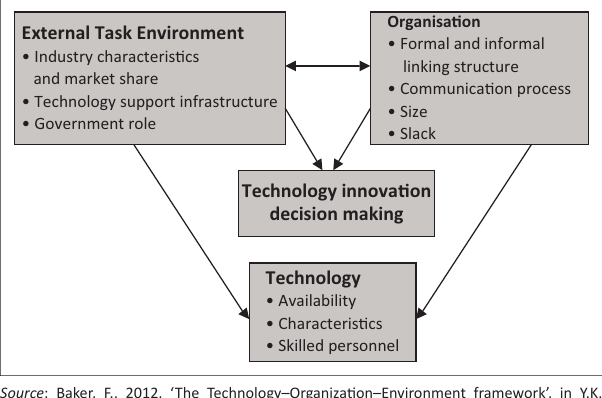
FIGURE 1: Technology Acceptance Model. FIGURE 2: Technology-Organisation-Environment